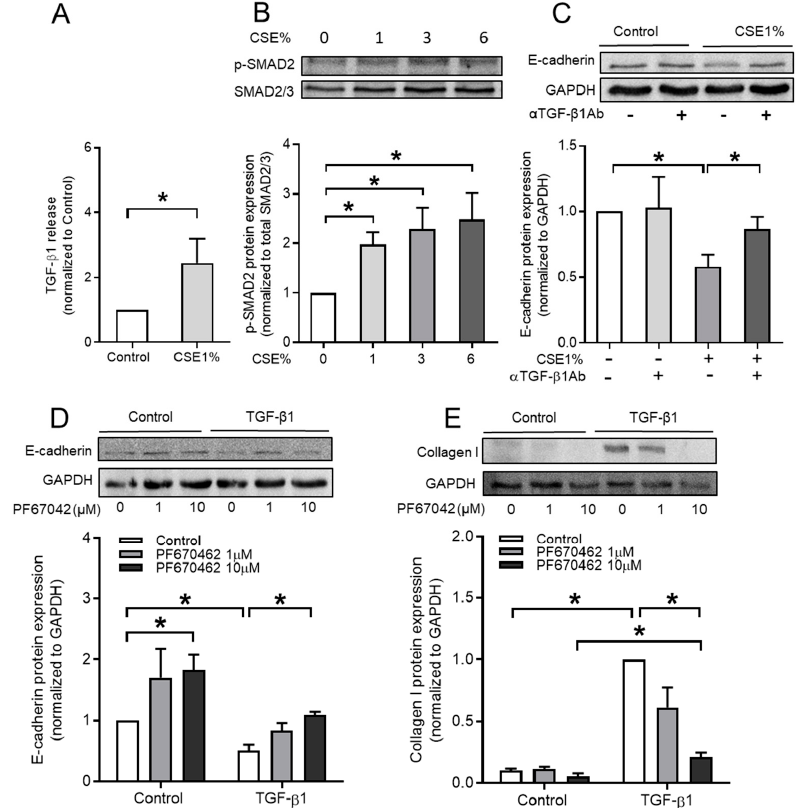
Figure 3. The e ff ect of CS extract on TGF- β 1 release, TGF- β 1 signaling, and TGF- β 1 induced EMT in BEAS-2B cells. The e ff ect of the δ / ε casein kinase I isoform inhibitor PF-670462. ( A ) TGF- β 1 release was measured by ELISA using the supernatant after 24 h 1% CSE exposure. ( B ) Representative western blotting images and quantification of phospho-SMAD2 in BEAS-2B cells treated with 24 h CS extract-incubated medium for 1 h. ( C ) BEAS-2B cells were pre-incubated with 10 ng/mL TGF- β neutralizing antibody for 30 min., following stimulated with 1% CSE for 24 h. Representative western blotting images and quantification of E-cadherin were shown. BEAS-2B cells were pre-incubated with 1 µ M or 10 µ M PF670462 for 30 min., following stimulated with 3ng / mL TGF- β 1 for 24 h. Protein ( D – E ) expressions of E-cadherin ( D ) and collagen Ӏ ( E ) were examined by western blotting. Data represent 3–6 independent experiments. Data are expressed as mean ± SEM, * p < 0.05; significant di ff erence between indicated